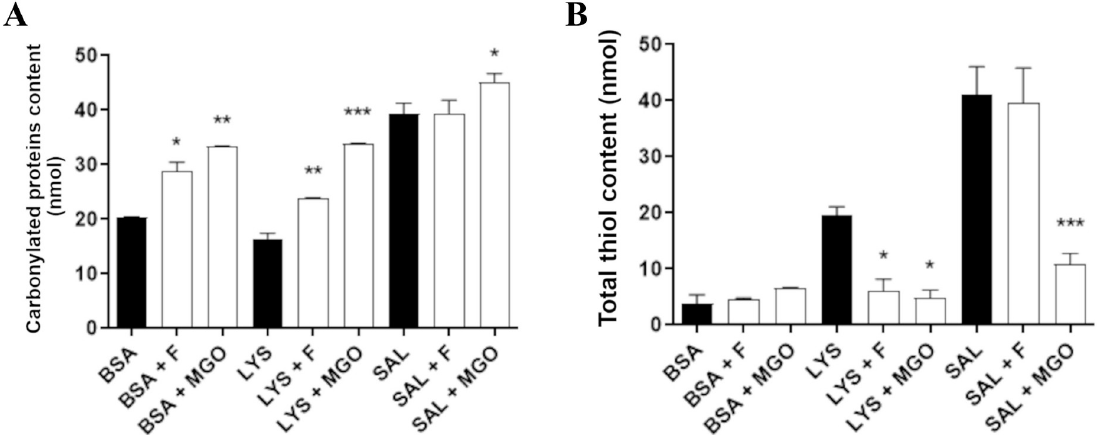
Fig 5. Carbonylated proteins (A) and total thiol contents (B) in non-glycated BSA, lysozyme and saliva, and glycated by fructose or MGO. � p < 0,05; �� p < 0,01; ��� p < 0,001.